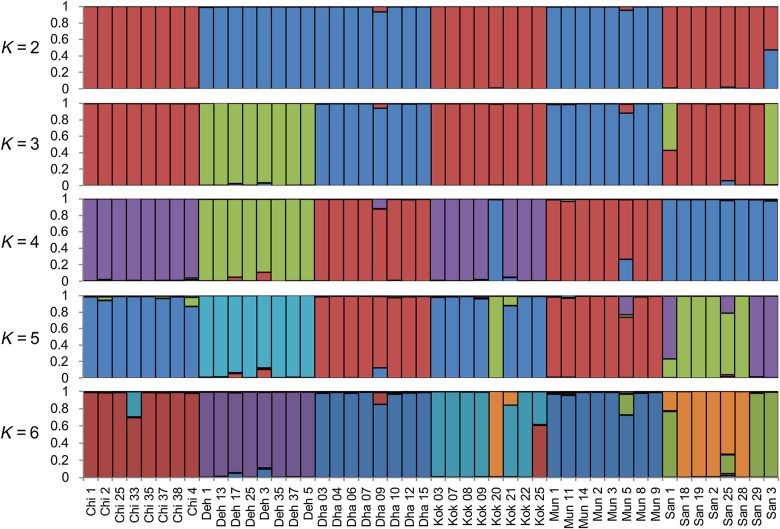
Genetic group assignment of west Himalayan accessions based on majority membership proportion inferred from K = 2 to K= 6 using STRUCTURE program. Each accession is represented by a single vertical line broken into K coloured segments, with lengths proportional to each of the K inferred clusters.